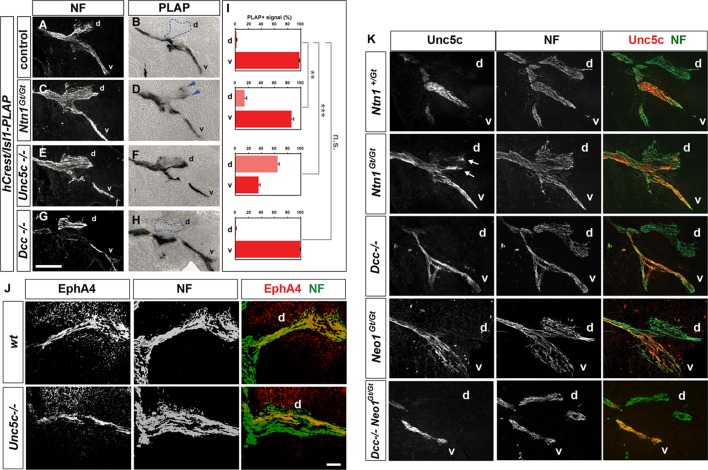
Analysis of medial LMC axon projections in mutant mice.Medial LMC axons were identified by genetic labeling with placental alkaline phosphatase (PLAP) (A–H) or identified with immunostaining for NF and EphA4 (J) or NF and Unc5c (K). (A–H) hCrest/Isl1-PLAP mice were crossed to wild-type, Dcc-/-, Ntn1Gt/Gt, and Unc5c-/- mice. Developing for alkaline phosophatase allowed the selective visualization of medial LMC axon projections. Immunostaining for NF in combination with alkaline phosphatase reaction in wild-type (A and B), Ntn1Gt/Gt (C and D), Unc5c-/- (E and F), and Dcc-/- (G and H) mice. (I) Quantification of the percentage of PLAP signal present in dorsal or ventral nerve branches. (J) Immunostaining for NF and EphA4 in e11.5 lumbar spinal cords of wild-type (top panels) and Unc5c-/- mutants (bottom panels). Note the overlap of NF and EphA4 in the dorsal branch of wild-type mice and the presence of a large cohort of EphA4-negative axons in the dorsal nerve of Unc5c-/- mice. (K) Analysis of Unc5c-expressing medial LMC axon trajectories in Ntn1Gt/Gt, Dcc-/-, Neo1Gt/Gt or double Neo1Gt/Gt, Dcc-/- mice. Limb sections were immunostained for NF and Unc5c (at a dilution in which motor but not sensory axons can be detected) in the different mutant mice as indicated. Note the presence of Unc5c-positive axons in the dorsal branch of Ntn1Gt/Gt mice. LMC, lateral motor column; NF, neurofilament; wt, wild-type; error bars = SD; *** = p<0.001; ** = p<0.01; n.s. = not significant; statistical significance computed using Student’s unpaired t test; all values are mean ± SD. Scale bars: (A–H, K) 80 μm; (J) 25 μm.